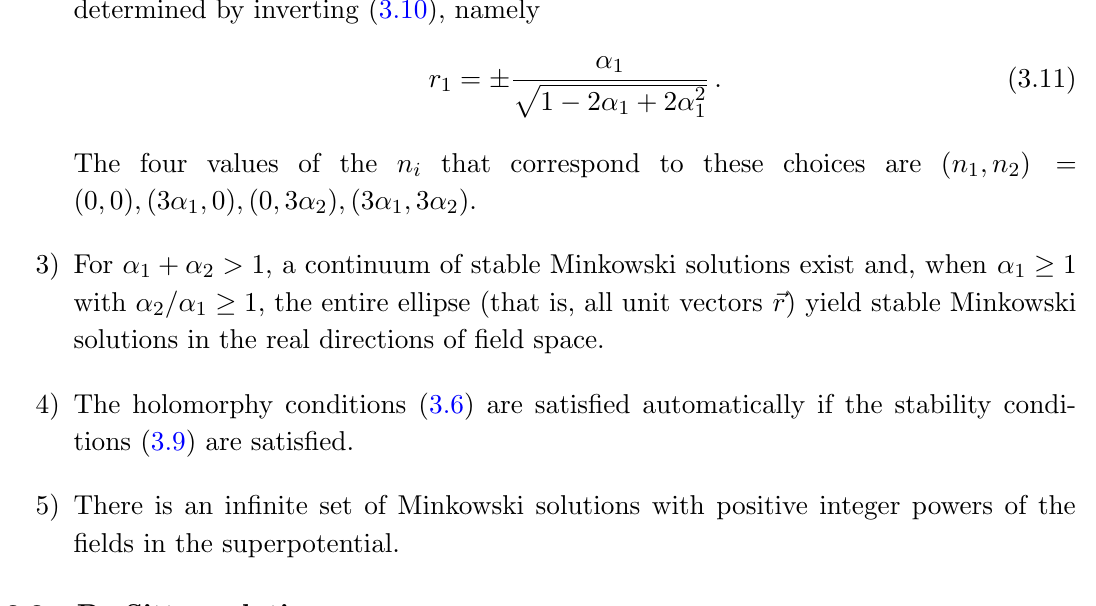
Figure 4 . Minkowski solutions for (cid:11) 1 = 1 = 4, (cid:11) 2 = 3 = 4 (lower ellipse) and (cid:11) 1 = 1 = 2, (cid:11) 2 = 3 = 2 (upper ellipse). In the former case only the four red points corresponding to ~r = ( (cid:6) 1 = are allowed, whereas in the latter case the red arc segments correspond to allowed